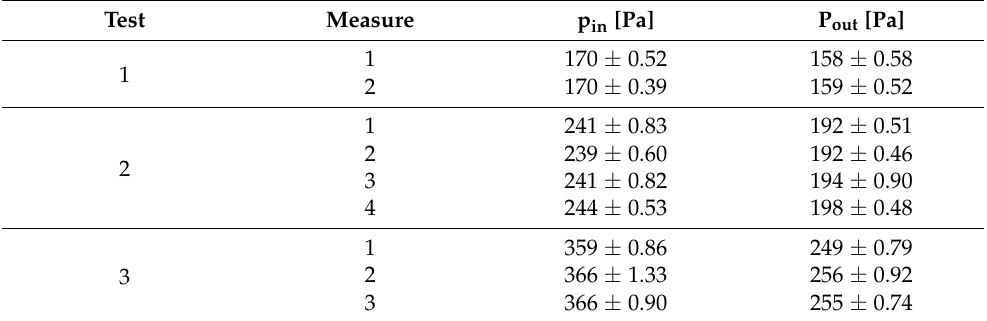
Table 2. Hydrogen partial pressure at the inlet and at the outlet of the PAV mock-up (with experi- mental uncertainty).